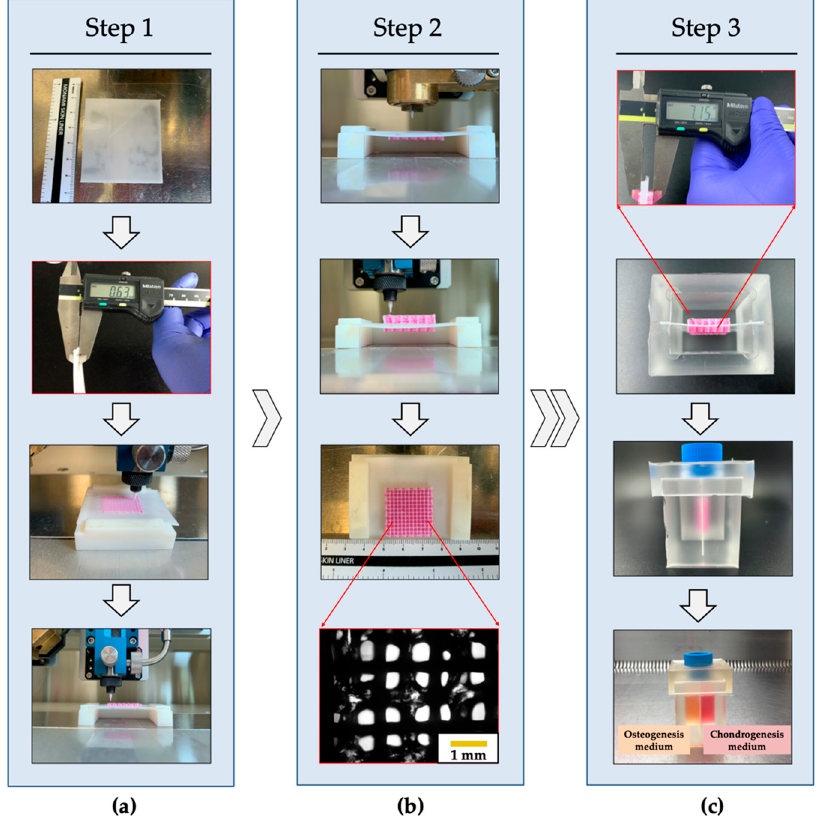
Figure 4. Printing process of the bipartite hybrid scaffold. ( a ) Hybrid scaffold printed on the PCL membrane. ( b ) Hybrid scaffold printed on the other side. ( c ) Bioprinted bipartite hybrid scaffold matured into osteochondral tissue in the PCSOT. Table 3. Fabrication conditions of the hybrid and bipartite hybrid scaffolds.